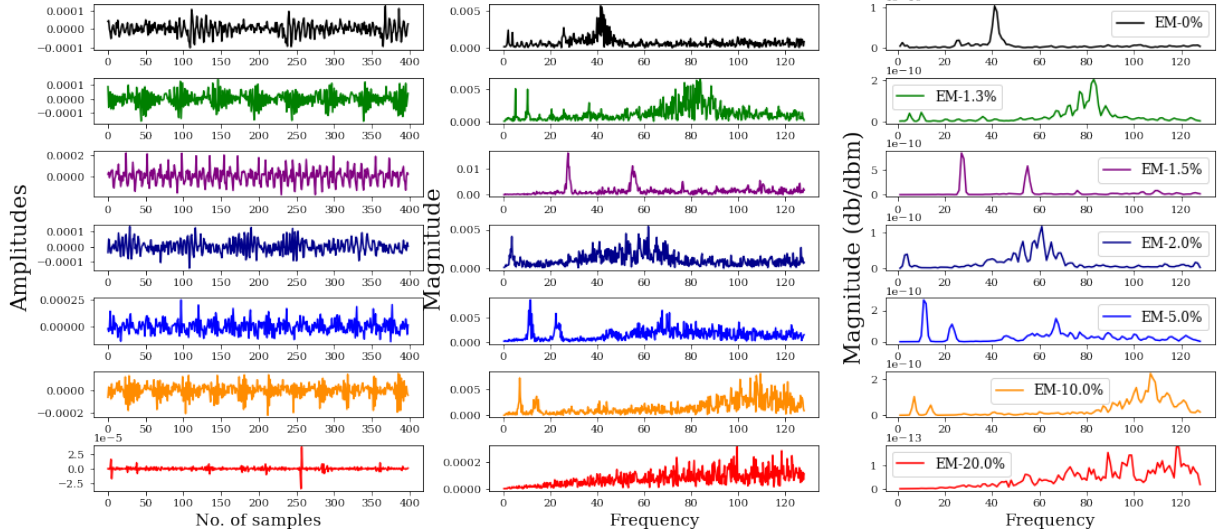
Figure A7. CR differentials and their FFT and PSD outputs at 1200 RPM for the emulsion compositions.